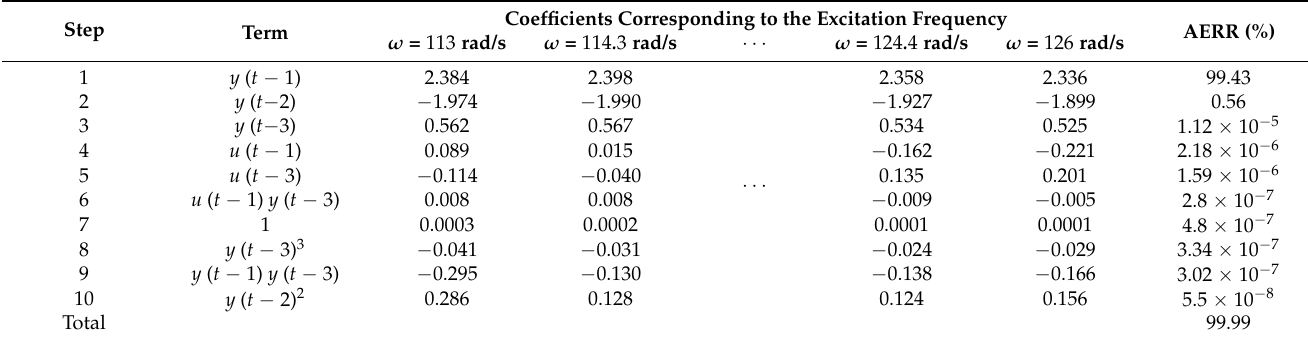
Table 5. The modeling results of the rotor test rig in Figure 11.